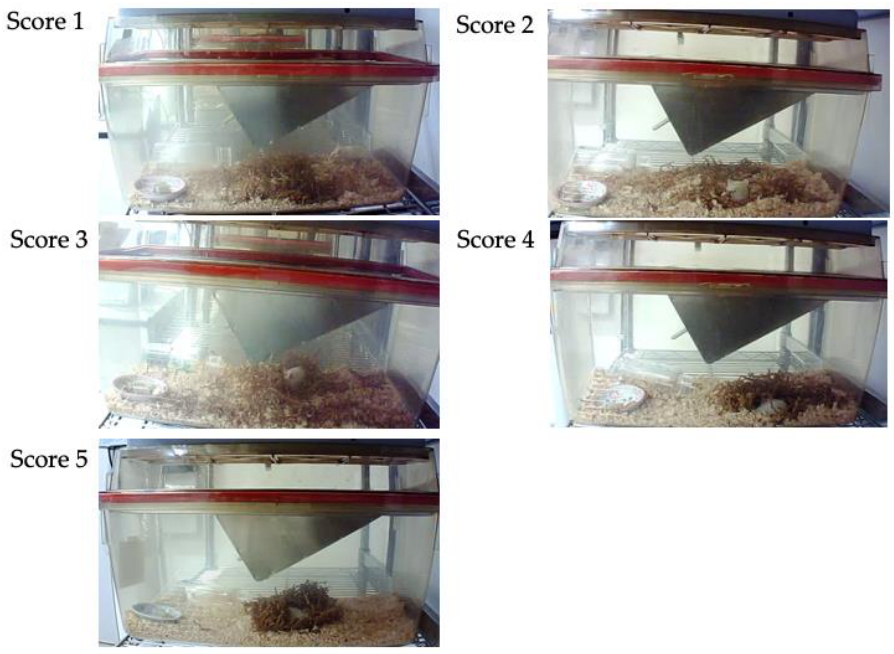
Figure 2. Nest consolidation